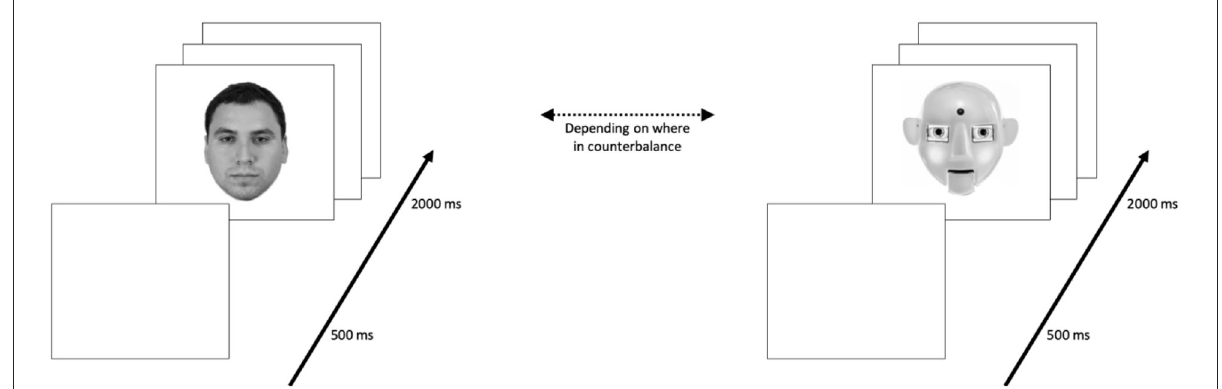
FIGURE2 Learning phase. Participants were first instructed they would see 20 upright human (or robot depending on counterbalance) faces and should attend to these faces in order to recognize them later. Participants then proceeded to the learning phase in which they passively viewed the 20 target faces which were displayed in a randomized order for 2,000ms each, with an ITI of 500ms.